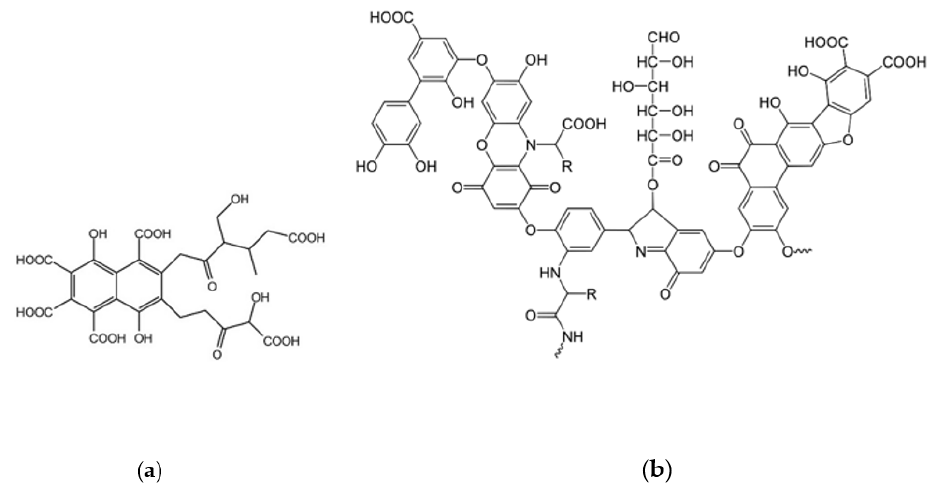
Figure 6. Organic humin-based chemical compounds are found in alginite: ( a ) the general chemical structure of fulvic acid; ( b ) humic acids.